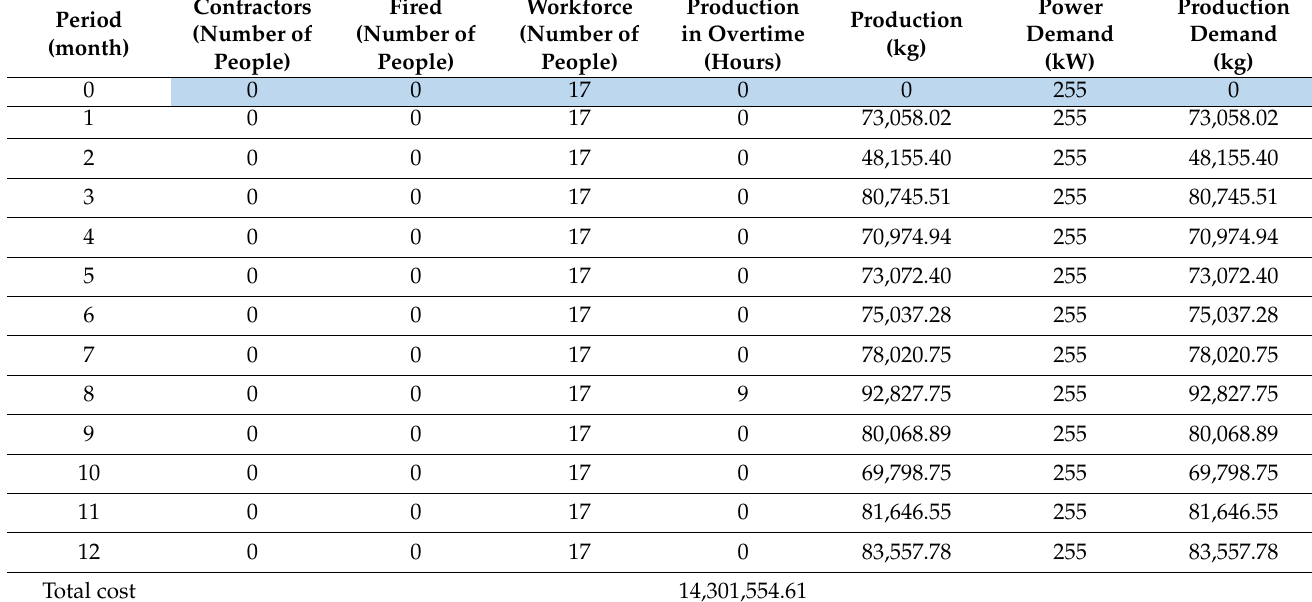
Table 4. Aggregate plan of the current scenario with the contracted power demand.